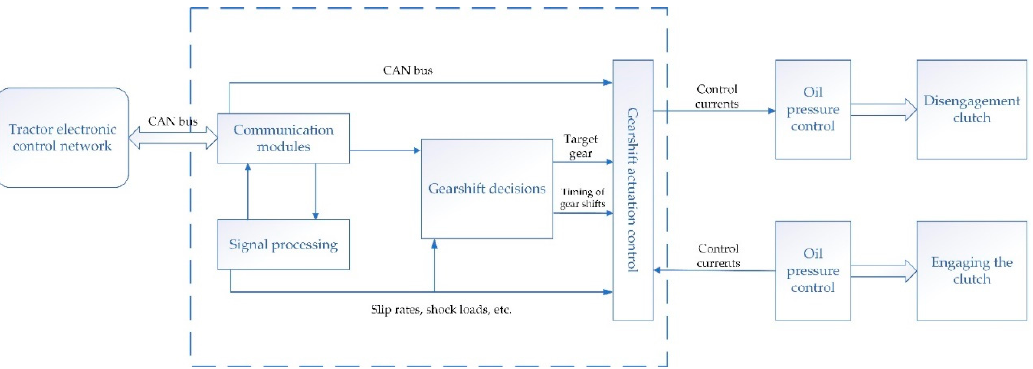
Figure 6. Power shift process.